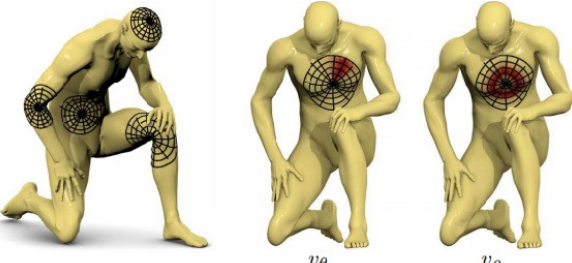
Figure 17. Visualized local geodesic polar coordinates. Left: examples of local geodesic patches, center and right: examples of angular weights and radial weights, v θ and v ρ , respectively (red denotes larger weights) [128]. ©2015 IEEE. Reprinted, with permission, from J. Masci, D. Boscaini, M.